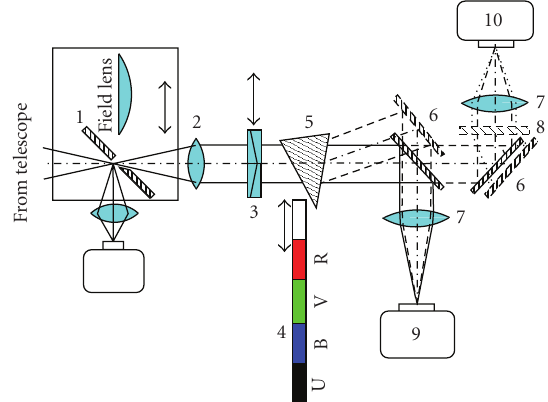
Figure 2: Concept of the FUSP. 1: movable mirror with the slit for a transmission of light to TV guiding camera, which may be replaced with the field lens; 2: collimator; 3: double Wollaston prism (polarizer); 4: movable U, B, V, R and white light filters; 5: movable spectral prism; 6: units of light transmission mirrors, movable synchronously with 5 and 8; 7: objectives; 8: di ff raction grating; 9: Position-Sensitive detector; 10: EM-CCD. The field lens is used on a telescopes with large relative apertures to achieve wider field of view without vignetting; for systems with smaller D/F ratio it may be